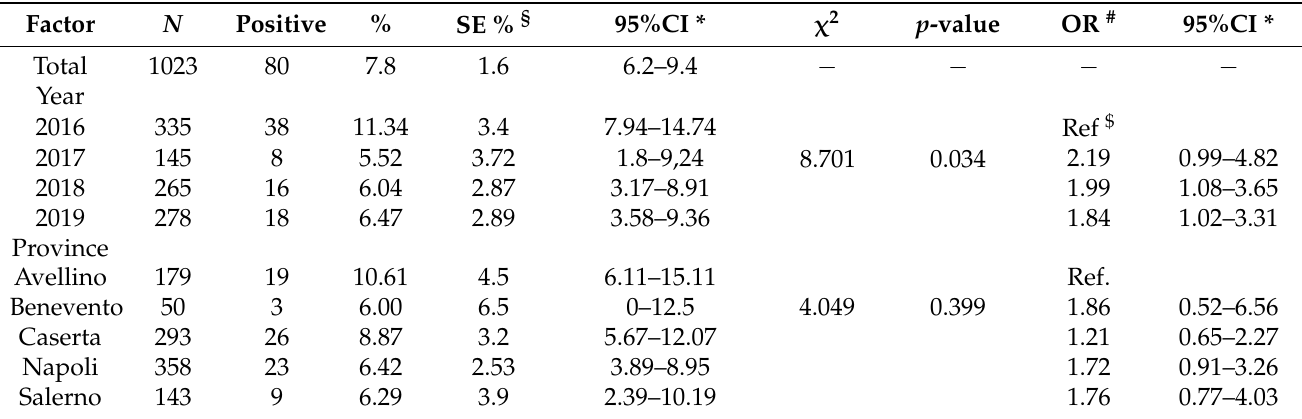
Table 4. Seroprevalence of infection with Anaplasma spp. and risk factor analysis by region and year in stray dogs in the Campania Region in 2016–2019 as detected by qualitative dot-ELISA SNAP 4DX ® (IDEXX Laboratories). Factor